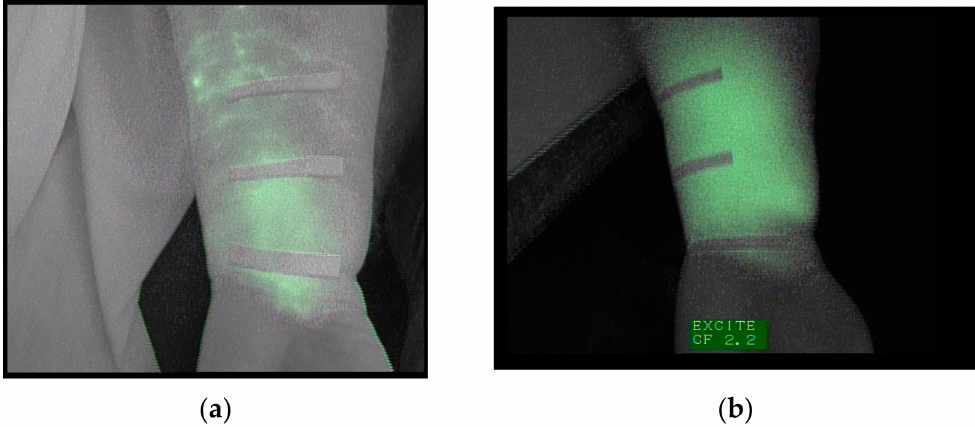
Figure 1. ( a ) Image of the forearm captured under basal conditions. ( b ) Image of the same forearm, taken after the treatment, depicting a widespread di ff use